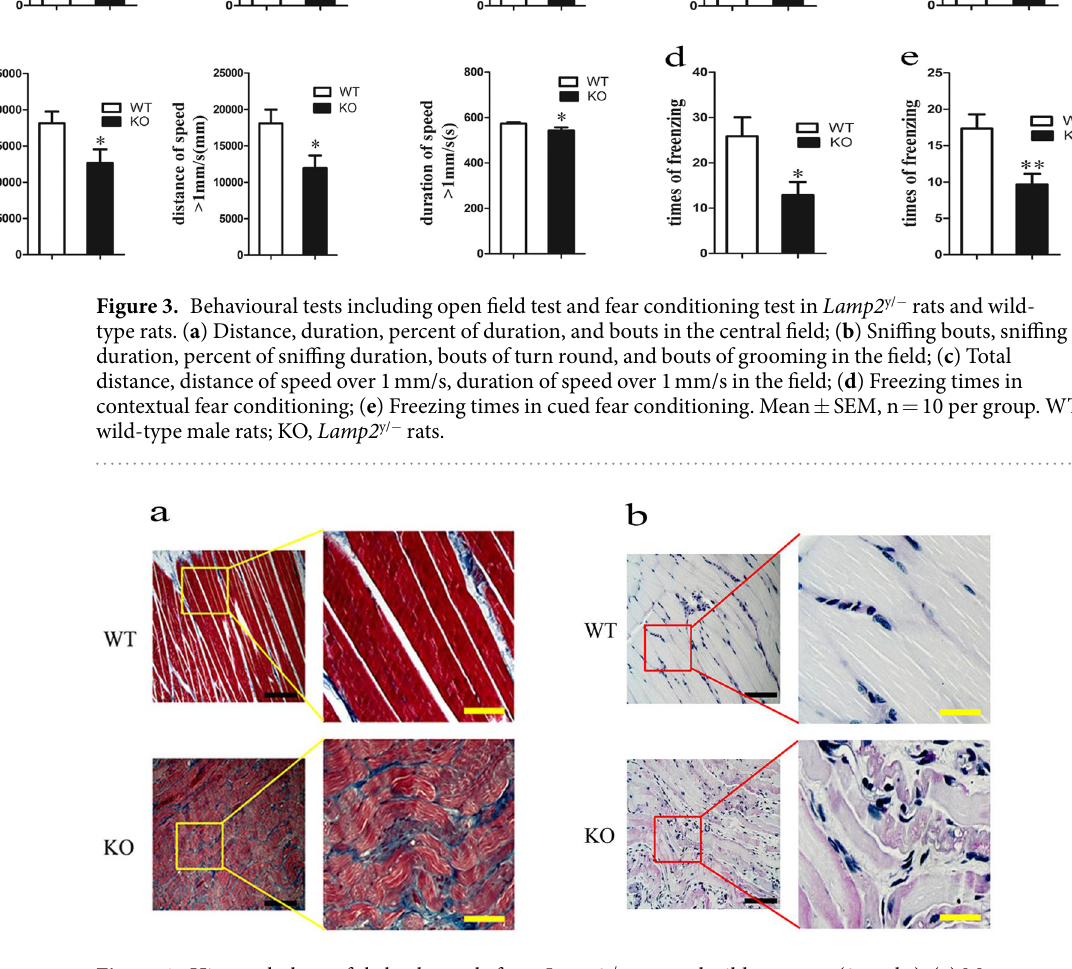
In addition, although there were increased nitrogen (BU) and creatinine (CRE) levels in serum (Table 1), and HE staining alterations (Fig. S3b) were not observed, the ultrastructure of the kidney in Lamp2 y/ − rats revealed foot process fusion of podocytes, indicating chronic kidney injury. Notably, no available Lamp2 − / − offspring due to Lamp2 y/ − sterility were obtained after monitoring for nearly 3 years, and the mean litter number reduced to 8 or 9 from Lamp2 + / − females compared with 12 or 13 in wild-type female rats (data not shown), indicating that lack of Lamp 2 might attenuate reproductive capacity.